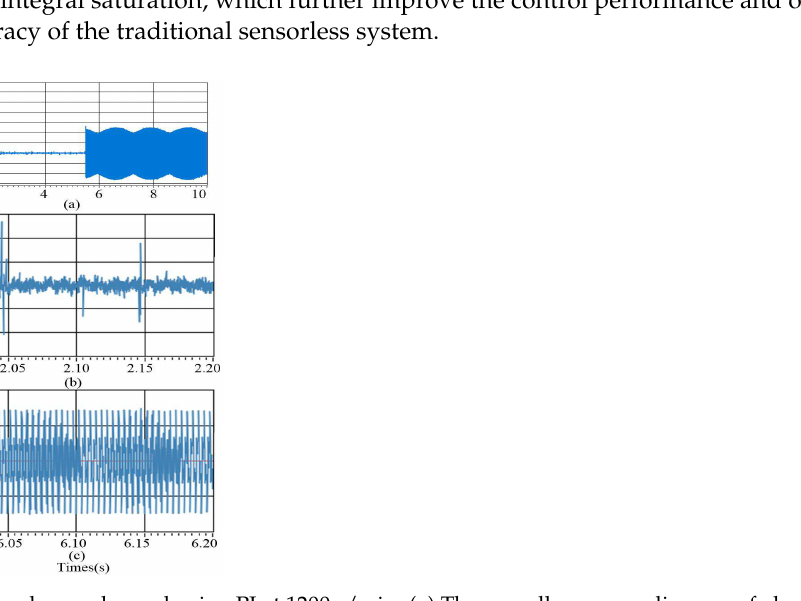
Figure 36. The observed speed using PI at 1200 r/min. ( a ) The overall response diagram of observed